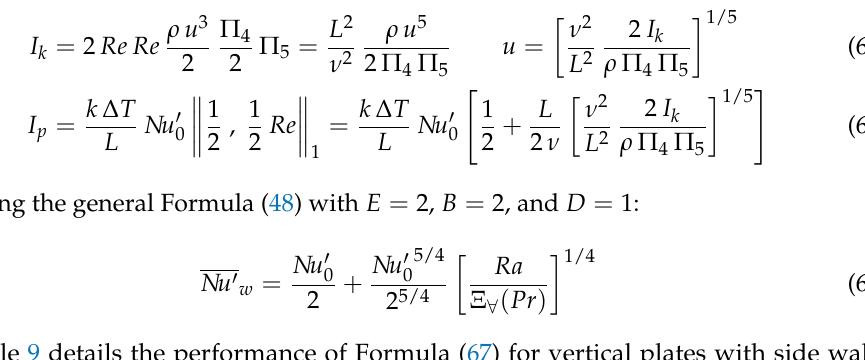
Table 9 details the performance of Formula (67) for vertical plates with side walls.